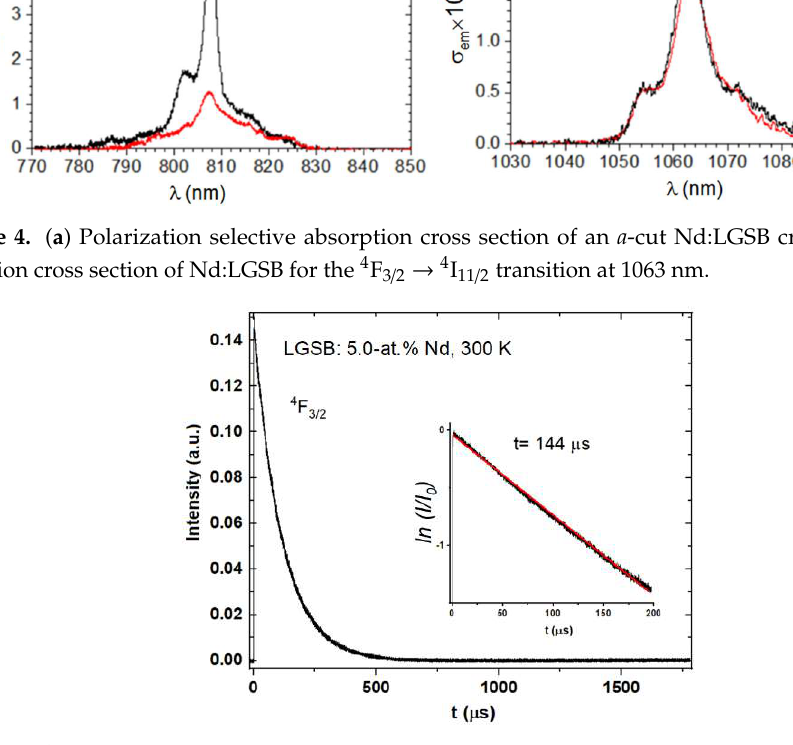
Figure 5. 4 F 3/2 decay curve measured at room temperature. Inset shows a logarithmic plot of the intensity and its corresponding linear fit (red line).